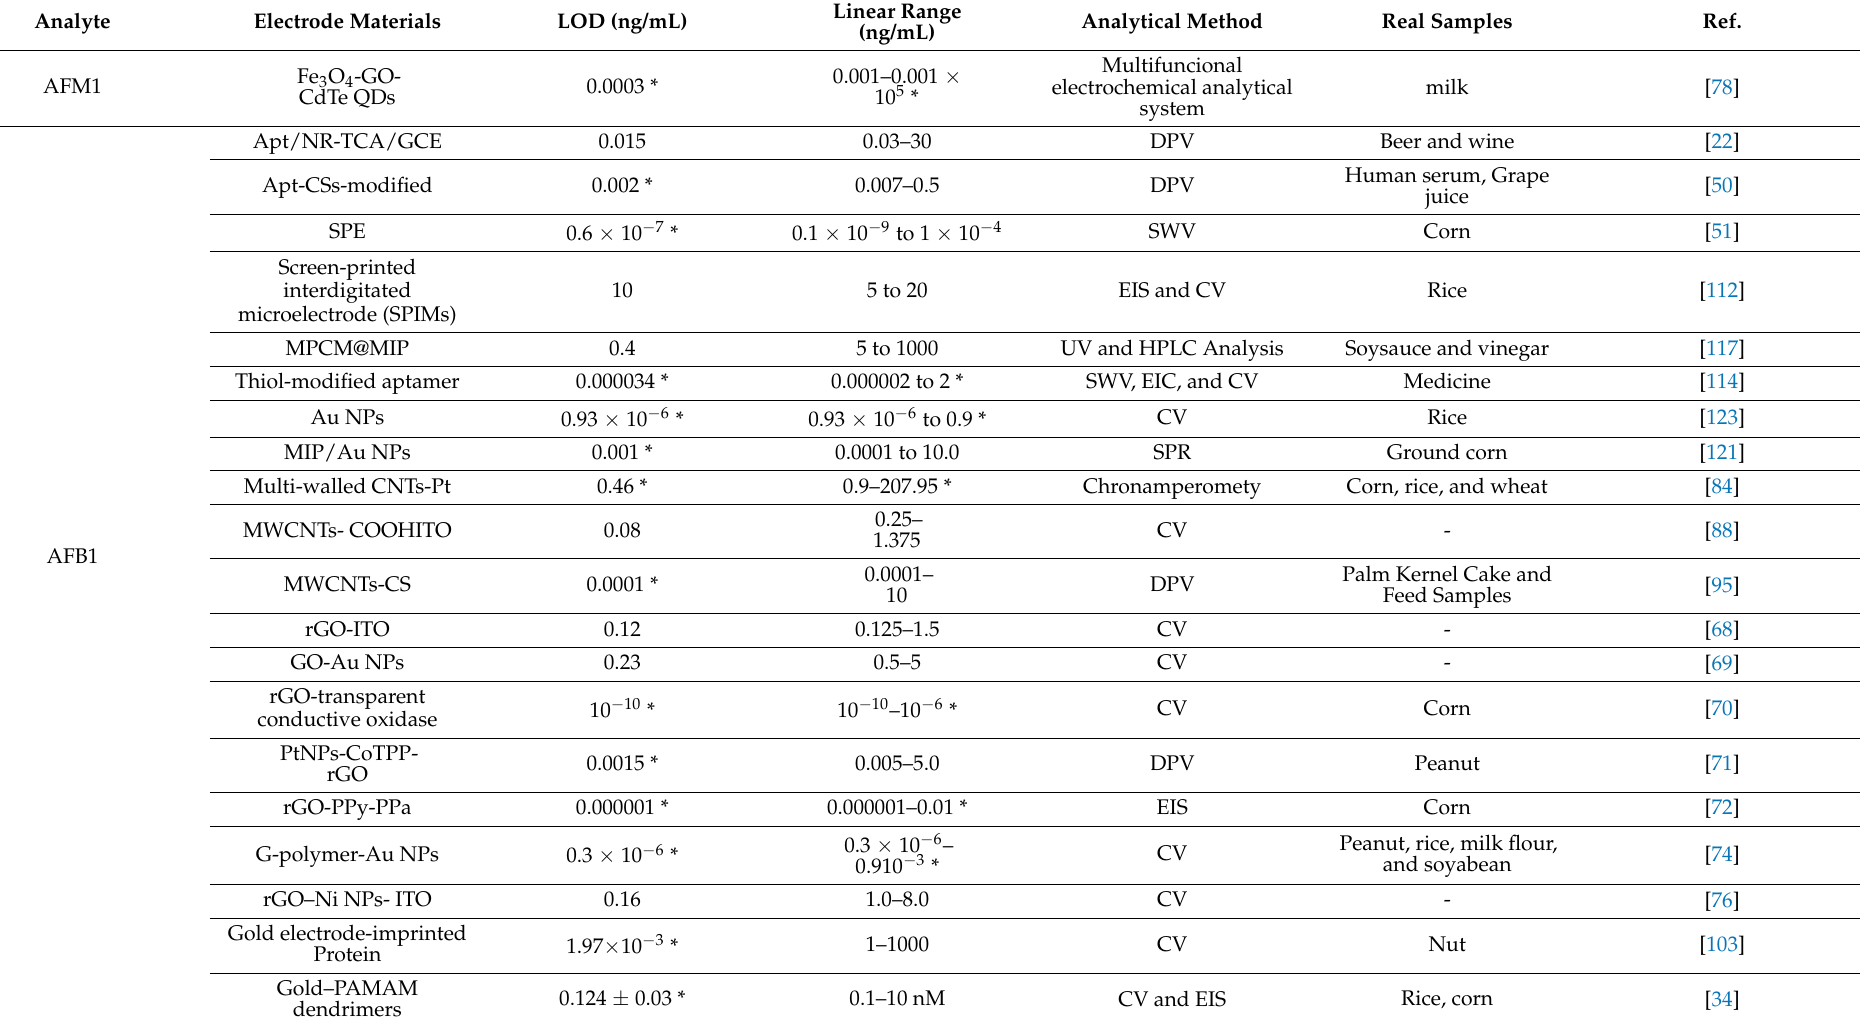
Table 1. Electrochemical biosensing of mycotoxins using recognition